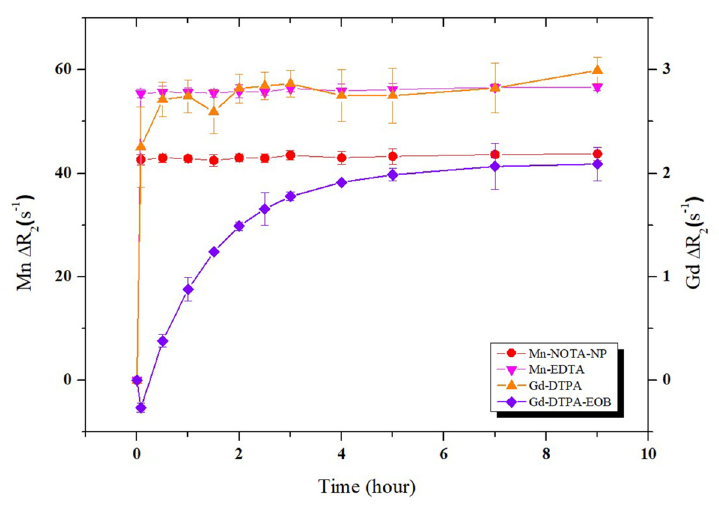
Figure 1. Transmetalation kinetics of 1 mM Mn-NOTA-NP ( ● ), Mn-EDTA ( ▼ ), Gd-DTPA ( ▲ ), and Gd-DTPA-EOB ( ■ ) over 10 mM Zn 2+ plotted by Δ R 2 as a function of time at 3 T and 293 K. Data are presented as n = 4 and mean ± SD (standard deviation).